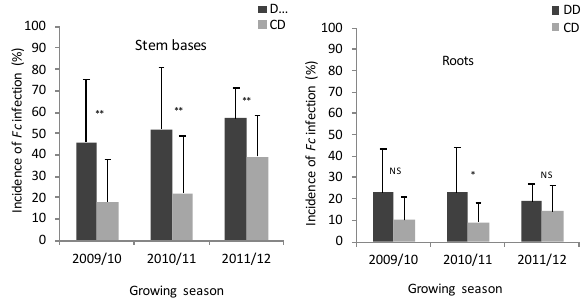
Figure 1. Mean incidence of Fusarium culmorum infections on stem bases and roots of durum wheat, oat or barley as affected by different sowing methods (DD vs CD) during three growing sea- sons. Error bars are 2 × standard deviations. NS: No significant dif- ference ( P > 0.05). *: significant difference ( P < 0.05). **: highly sig- nificant difference ( P < 0.01) according to Student’s